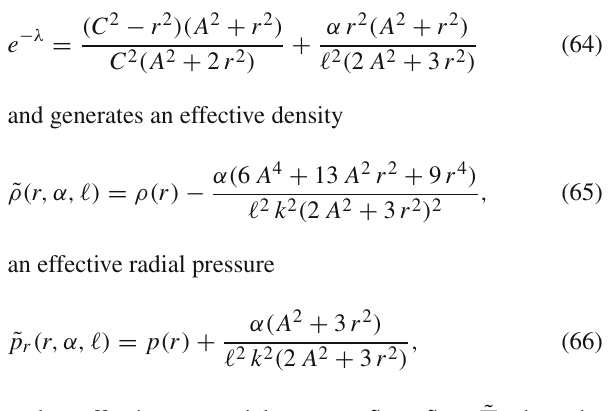
wecangenerateacontinuousfamilyofsystemswithdifferent mass M (cid:12) and radius R (cid:12) but the same total complexity factor Y TF in Eq.